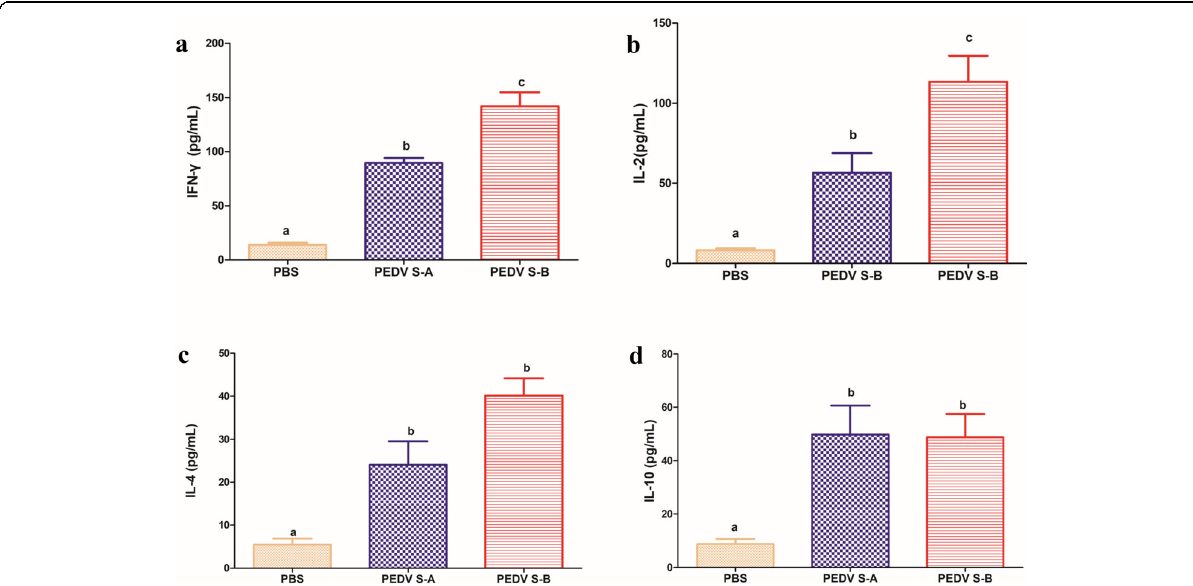
Fig. 5 Cytokine levels in the culture supernatants. IFN- γ ( a ), IL-2 ( b ), IL-4 ( c ), and IL-10 ( d ) levels were measured by double-antibody sandwich ELISA. Data were represented as the mean ± SEM. Different letters ( a , b ) indicate a statistically significant difference between different experimental groups ( P < 0.05). PEDV, porcine epidemic diarrhea virusPEDV, porcine epidemic diarrhea